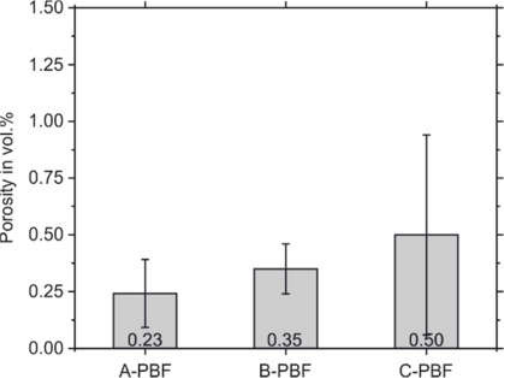
Figure 5. Porosities of the PBF-LB/M-processed samples.